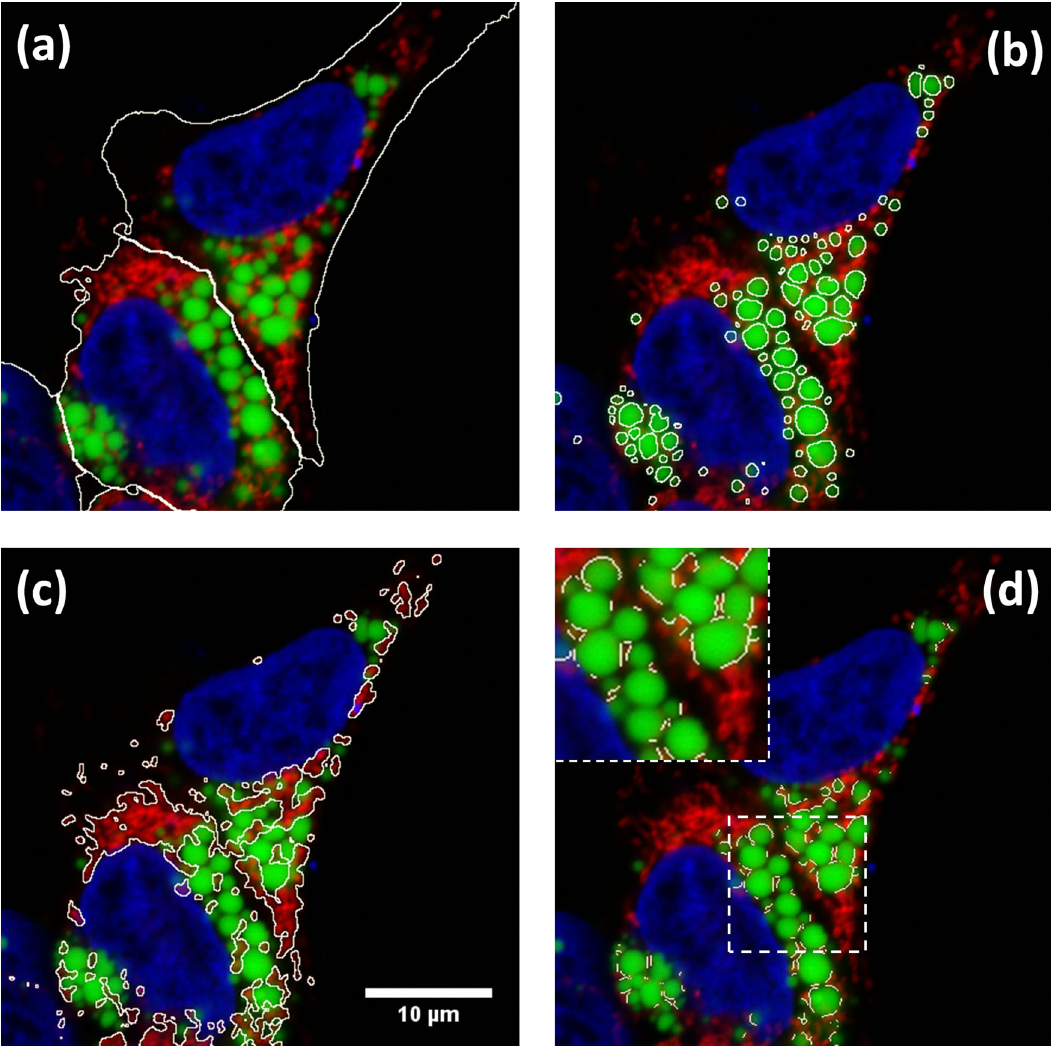
Figure 2. Results of ContactJ macro. Hek293 cells were labelled with anti TOM20 antibody (mitochondria) in red, Bodipy493/505(LDs)ingreenandDAPI(nuclei)inblue.Thedifferentregionsofinterestresultingfromsegmentation are highlighted in white (a) Cell Segmentation, (b) LD segmentation, (c) mitochondria segmentation and (d) LD-mitochondria contacts. Insert in d) shows a detail of how contact regions found by ContactJ are accurate and individualized per